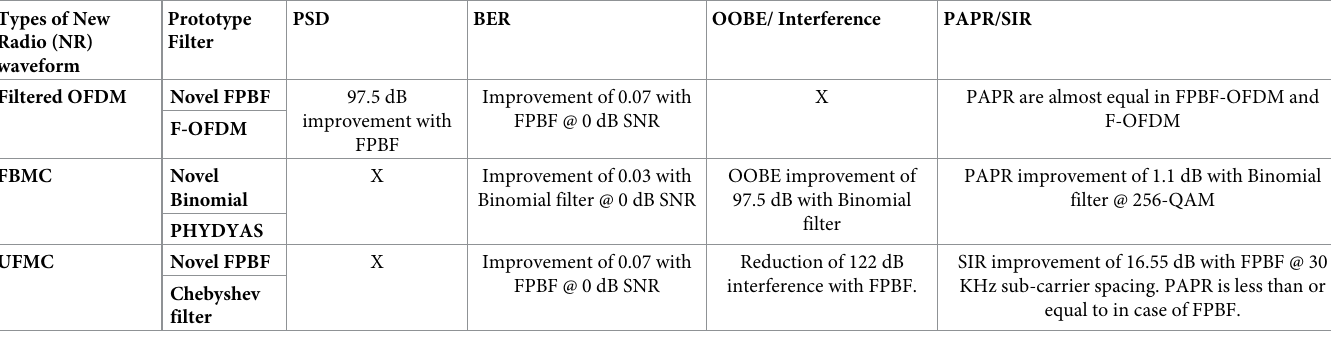
Table 3. Performance comparison of different New Radio (NR)